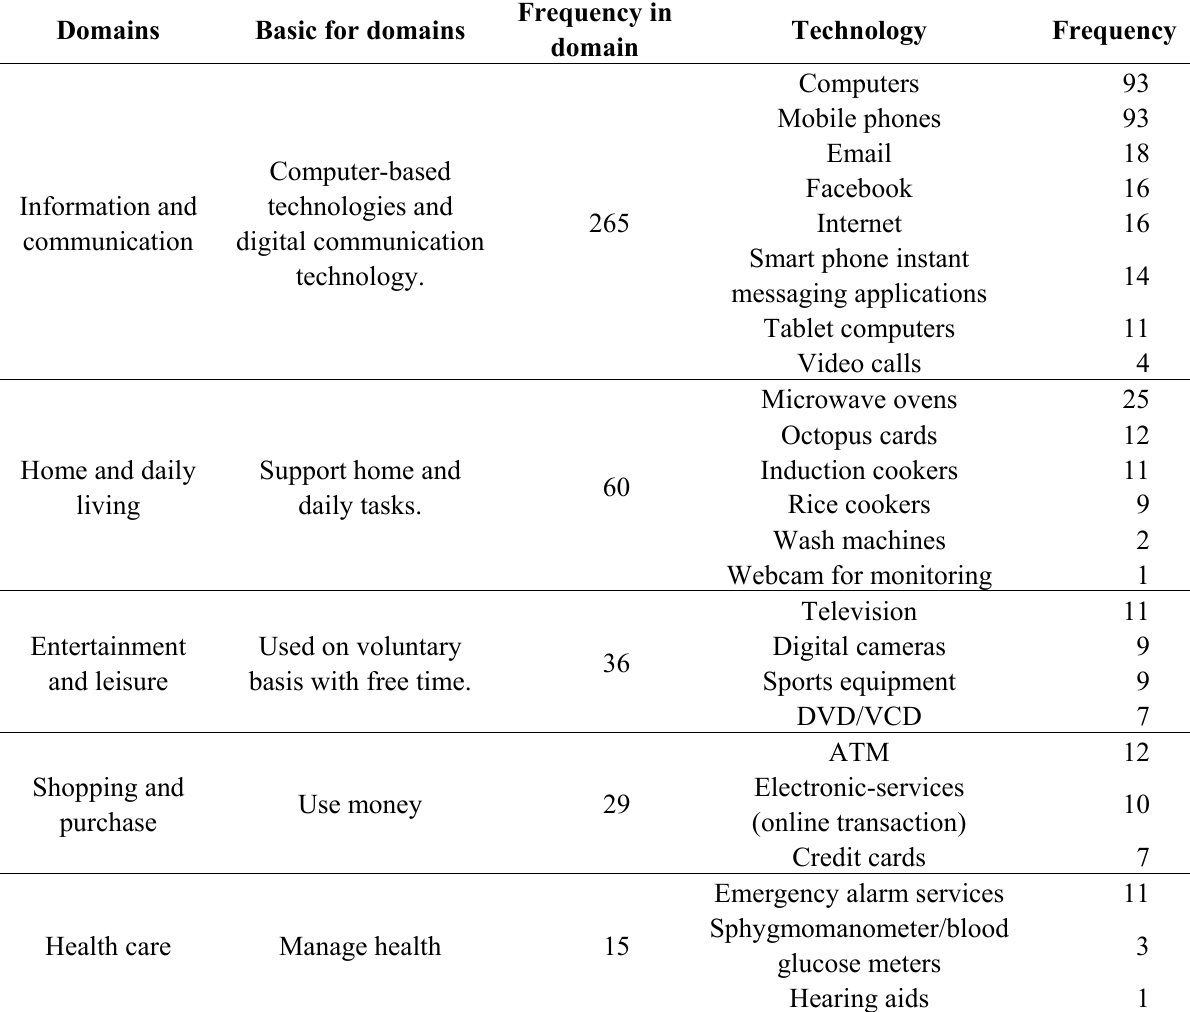
Table 4. The frequency with which technologies were discussed in each domain ( n = 405).